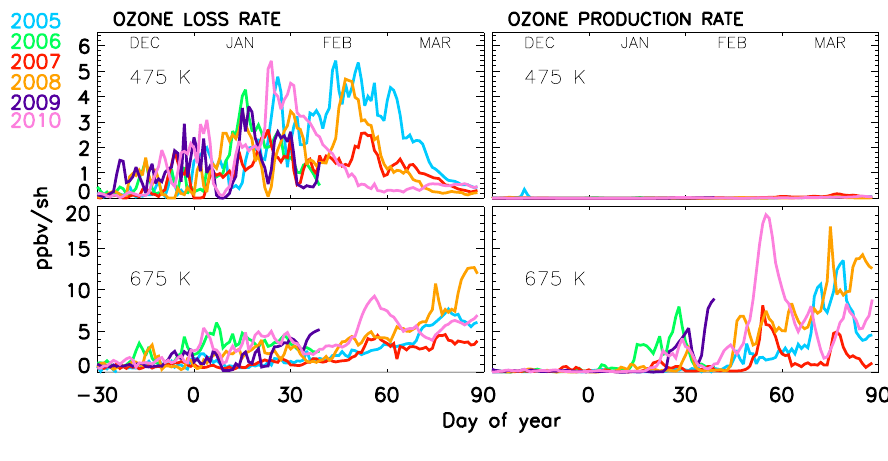
Fig. 6. Vortex averaged ( ≥ 65 ◦ EqL) chemical ozone loss and production rates at 475 and 675K, expressed in ppbv per sunlit hour (ppbv/sh), for the Arctic winters 2005–2010. The data are exempted from temporal smoothing to explicitly show the effect of daily movement of vortex and its impact on ozone production and loss